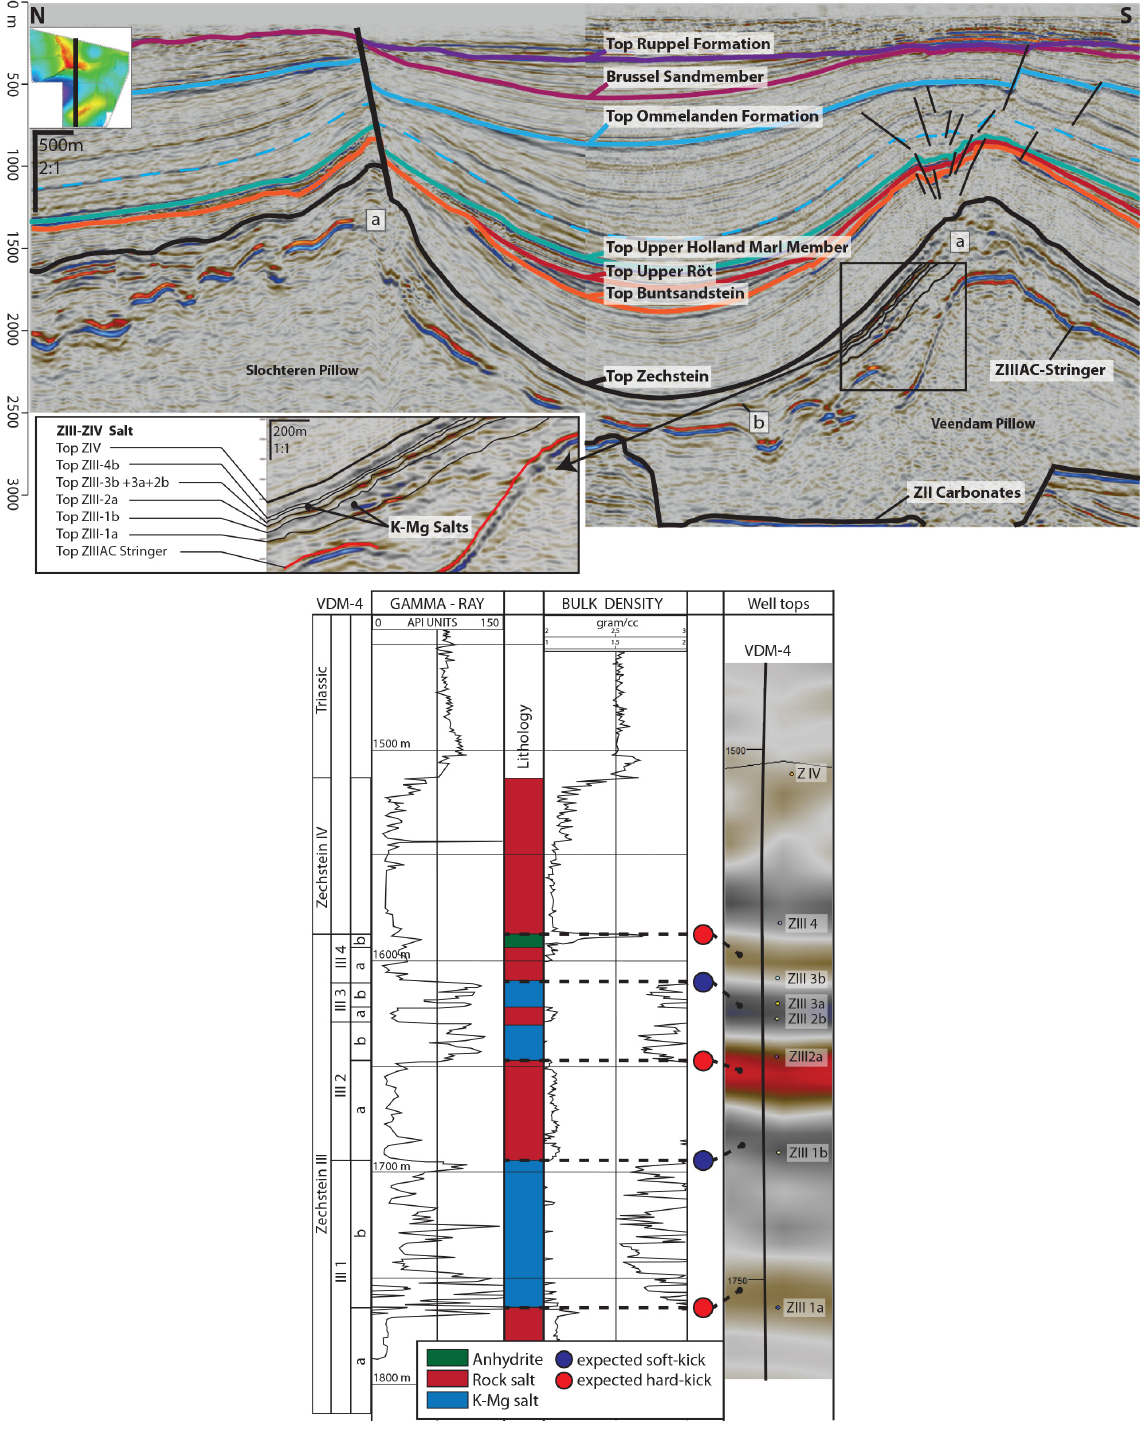
Figure 2. N–S profile through the study area with the Slochteren Pillow in the north (volume 2) and the Veendam Pillow in the south (volume 1). The black lines indicate a normal fault at the south margin of the Slochteren Pillow and smaller faults above the Veendam Pillow forming a crestal collapse graben. The basin between the pillows shows significant thickening of most layers. The Z3 stringer is separated under the basin and folded and thrusted in the pillows. Bottom: detailed view of the salt layers in the top of the salt bodies. (a) Decline of seismic quality in the pillow crest. (b) Merging of reflections under the basin. VDM-4 Well-log and expected seismic response compared to the real seismic